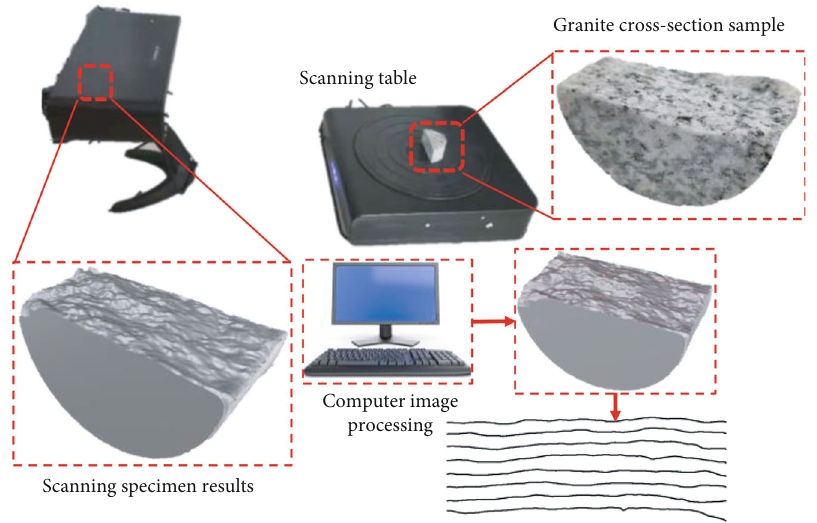
Figure 13: Fractal acquisition of granite specimen